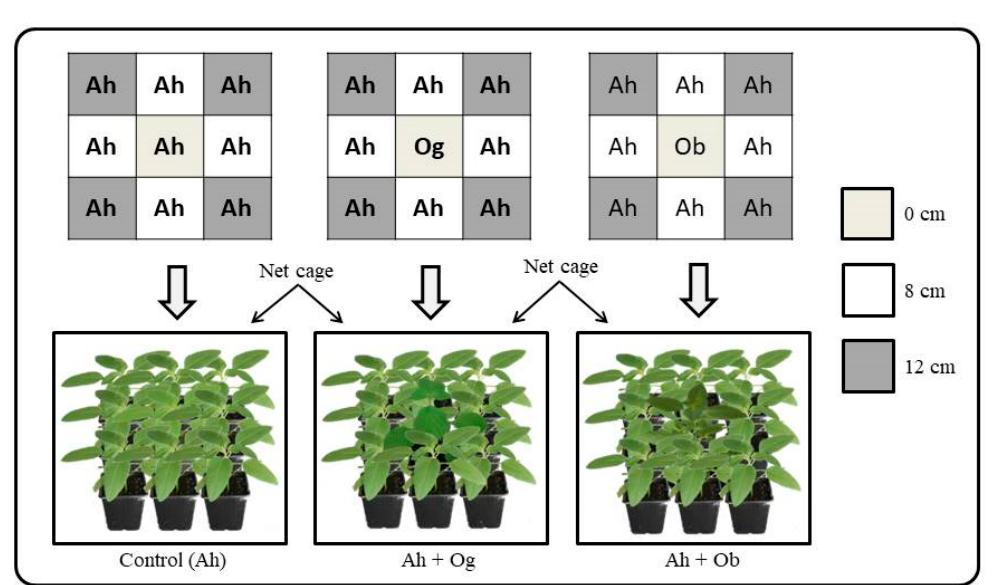
Figure 1. Illustration of the di ff erent treatments. Ah: A. hybridus , Og: O. gratissimum , Ob: O. basilicum , control ( A. hybridus alone), 8 cm and 12 cm: distance to the central plant (0 cm) . Psp: percentage of aphids on selected plant (plants at 8 cm and 12 cm), Pcp: percentage of aphids on central plant ( A. hybridus or Ocimum ). Repellent index ranging from -1.00 to 1.00. Negative value indicates attractant e ff ect toward the central plant, and positive value indicates a repellent e ff ect to the central